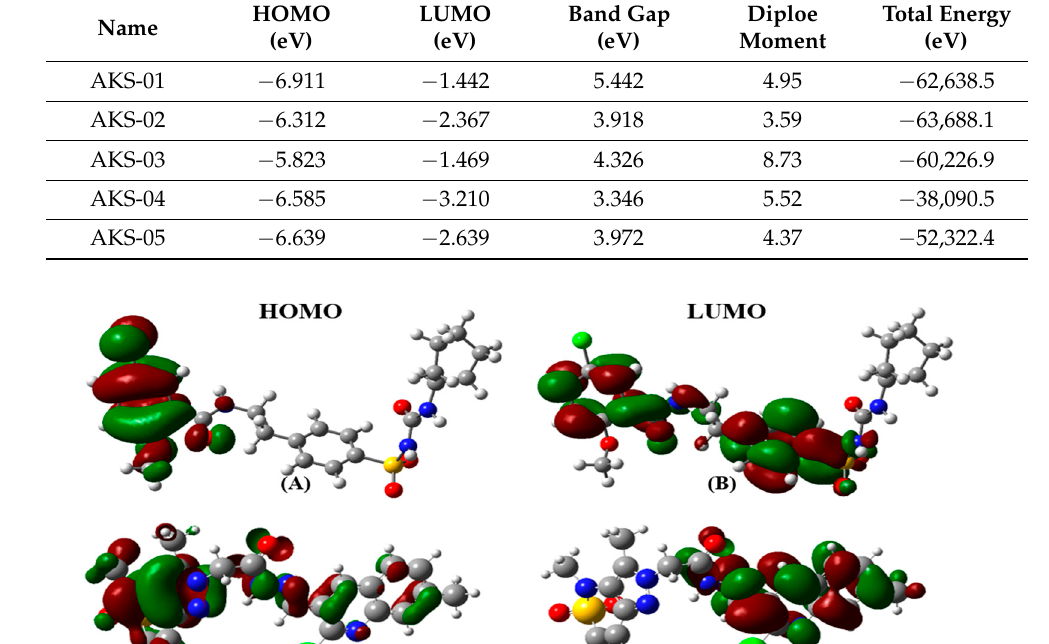
Table 2. Thermodynamics parameters and molecular orbital energy values of selected hit compounds.